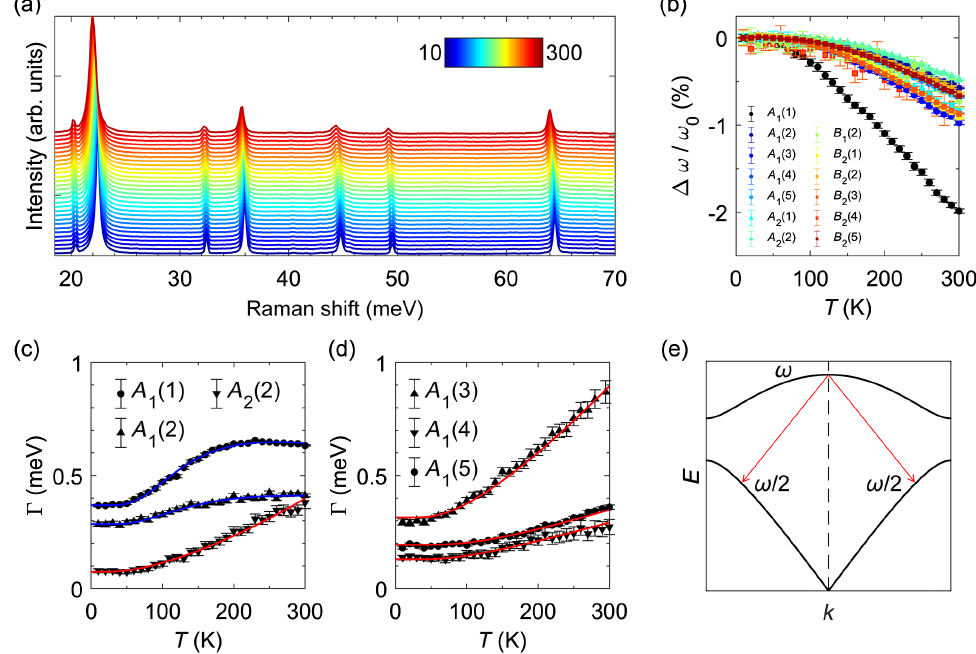
FIG. 2. (a) Temperature-dependent Raman spectra from 10 to 300 K. Spectra are vertically offset. (b) Percent difference of the phonon energies from the ω 0 value at 10 K as a function of temperature. The lowest-energy A 1 mode changes by twice the percent of any other mode. (c) Linewidth temperature dependence of the A 1 ð 1 Þ and A 1 ð 2 Þ modes, which have energies 22.4 and 35.8 meV at 10 K, respectively. The A 2 ð 2 Þ mode at 32.4 meV has an energy between that of the two A 1 modes. While both A 1 modes display an anomalous temperature dependence, the A 2 mode temperature dependence is that expected from anharmonic phonon decay. Fits in blue and red are those assuming decay into electron-hole pairs and acoustic phonons, respectively. (d) Three higher-energy A 1 modes, which also display the temperature dependence expected from anharmonic decay. (e) Schematic diagram showing the lowest-order anharmonic decay of an optical phonon with energy ω decay into two acoustic phonons with energy ω = 2